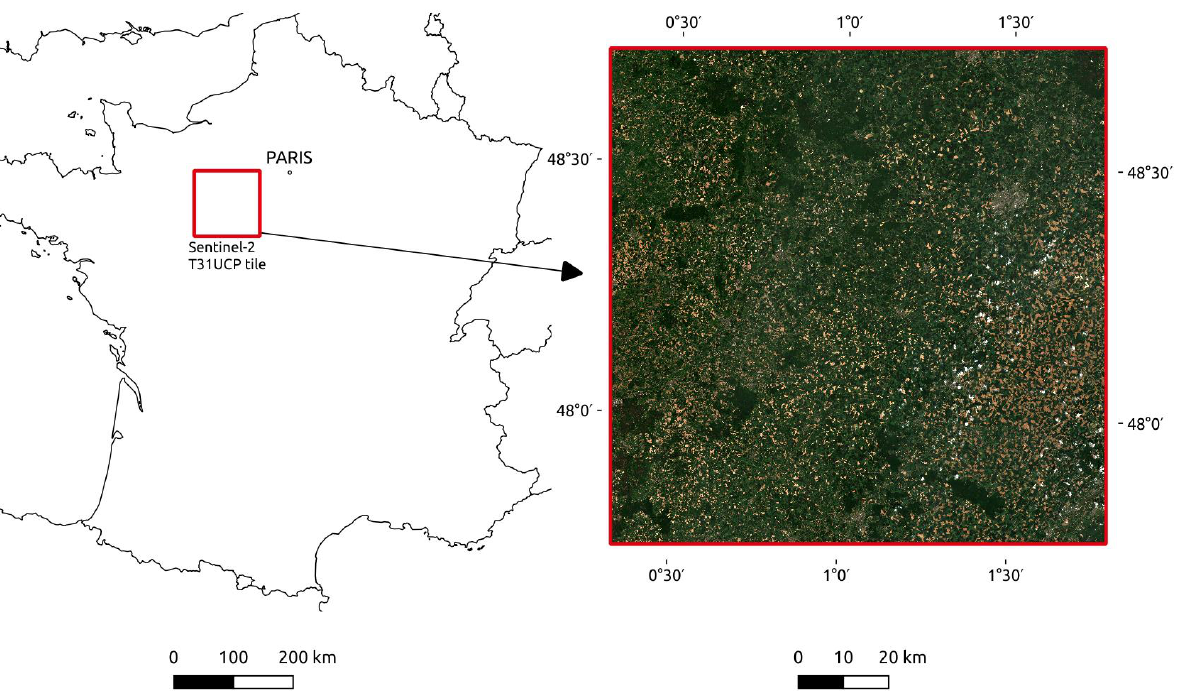
Figure 1. The Sentinel-2 tile T31UCP considered in this work is located in the Beauce area (near Paris) and delimited by the red box. On the right, the S2 image processed in level 2A acquired in May 19 2018 is displayed in natural